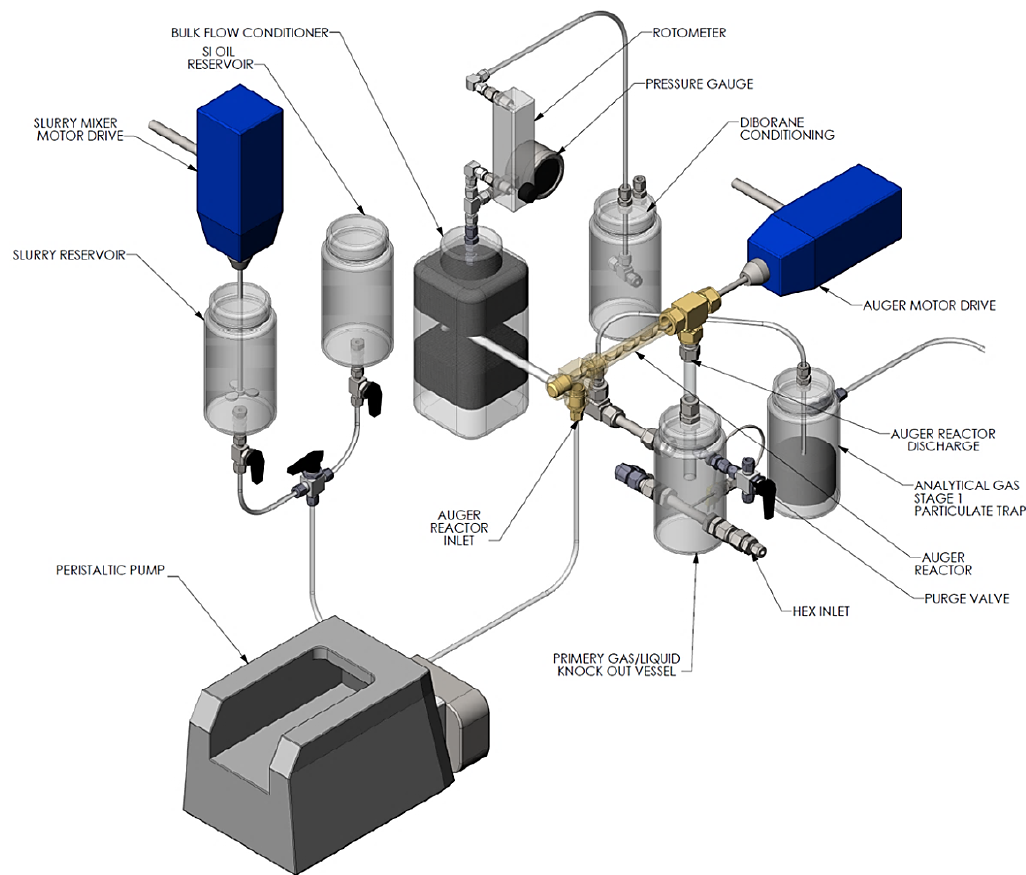
Figure 11. Auger reactor used for alane and ammonia borane (AB) slurry feeds.